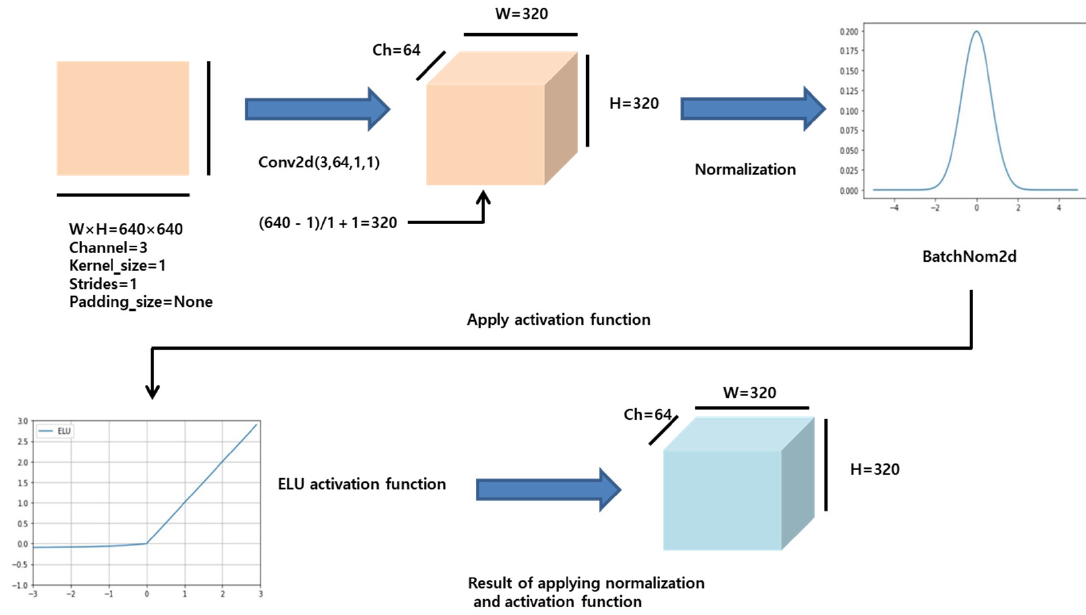
Figure 6. Flowchart of ConvELU layer (the way we suggest it).